Question: Express in one sentence what the figure is showing.
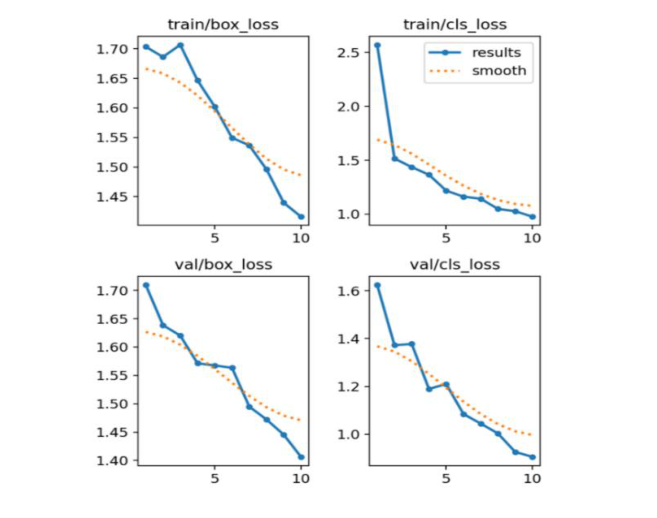
Answer: Loss of Boxes and Classes in YOLOv8